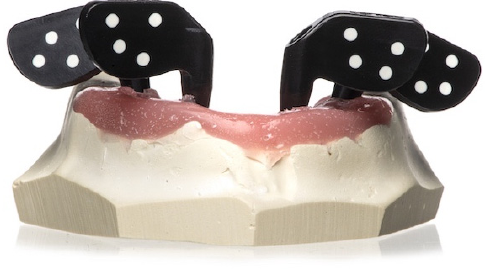
Figure 3. PiC transfers screwed on the reference model.